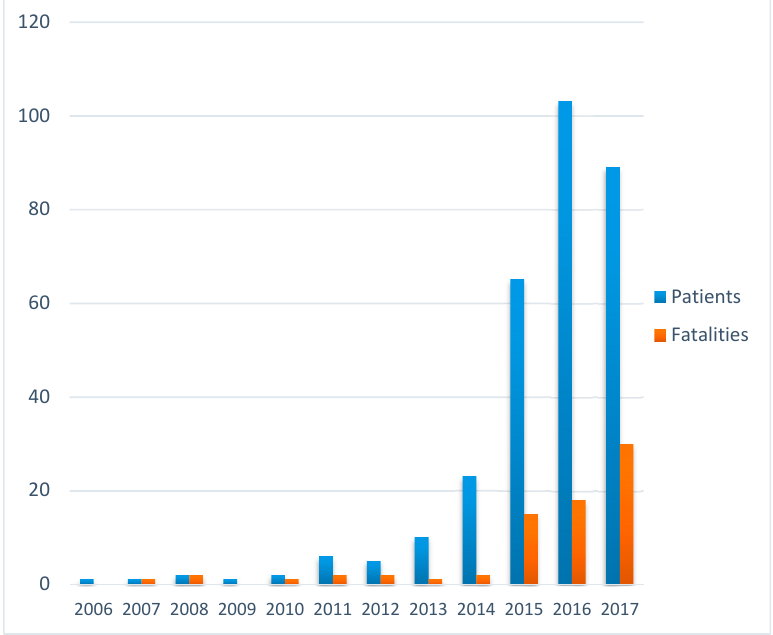
Figure 1. Annual incidence of cases and fatalities (2017 data only up to March).